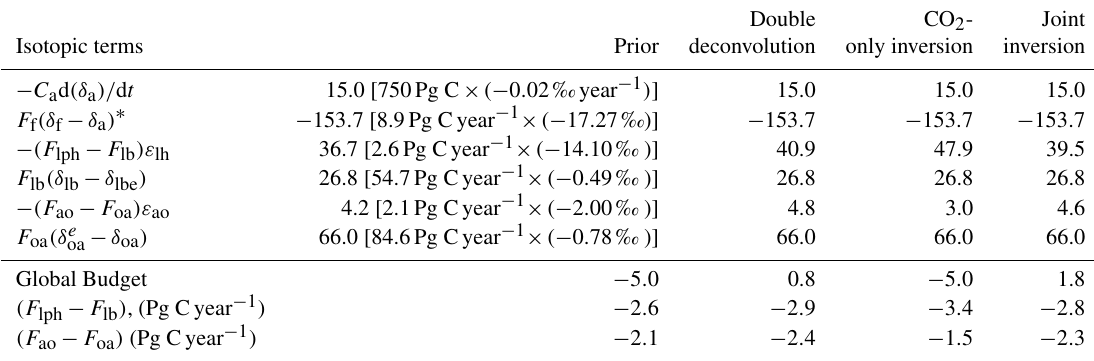
inversion results are analyzed in Sect.